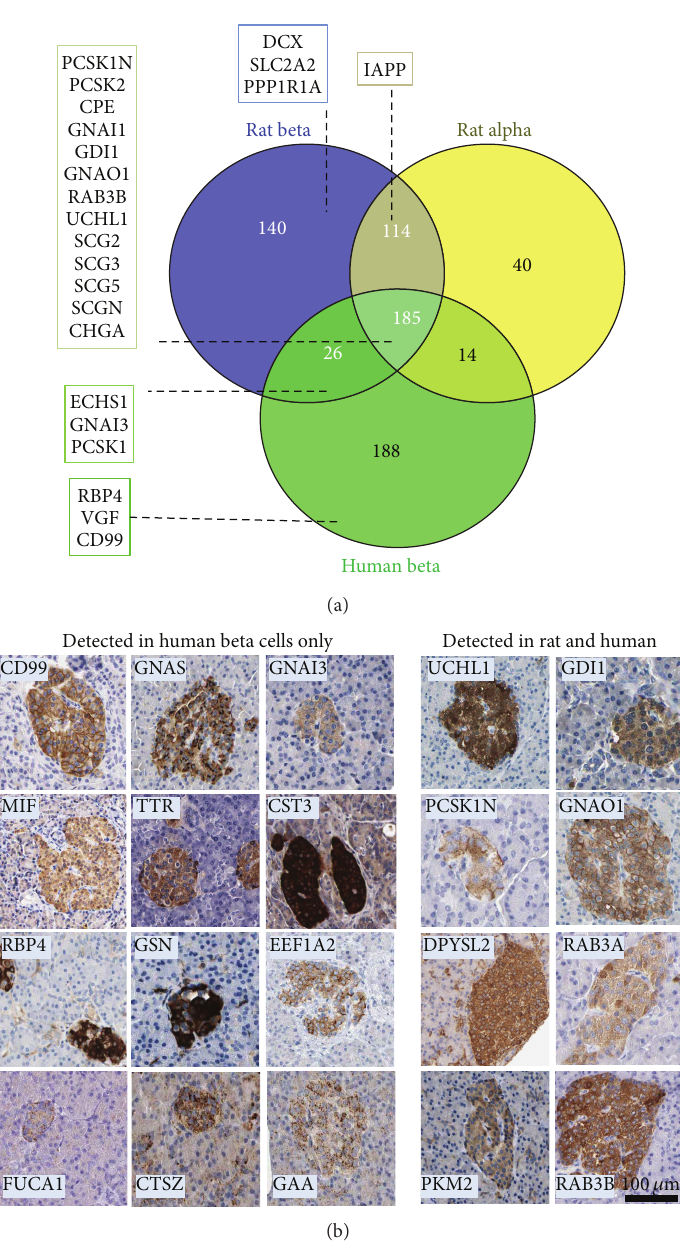
Figure 1: Overview of the LC-MS/MS data set and novel endocrine markers. (a) Venn diagram of number of proteins uniquely or commonly identified in human beta cells ( 𝑛 = 4 ) and rat alpha and beta cells ( 𝑛 = 3 ). Full list in Table S1. (b) Proteins with islet-restricted expression in pancreas according the Human Protein Atlas detected in both rat and human beta cells, or only in human beta